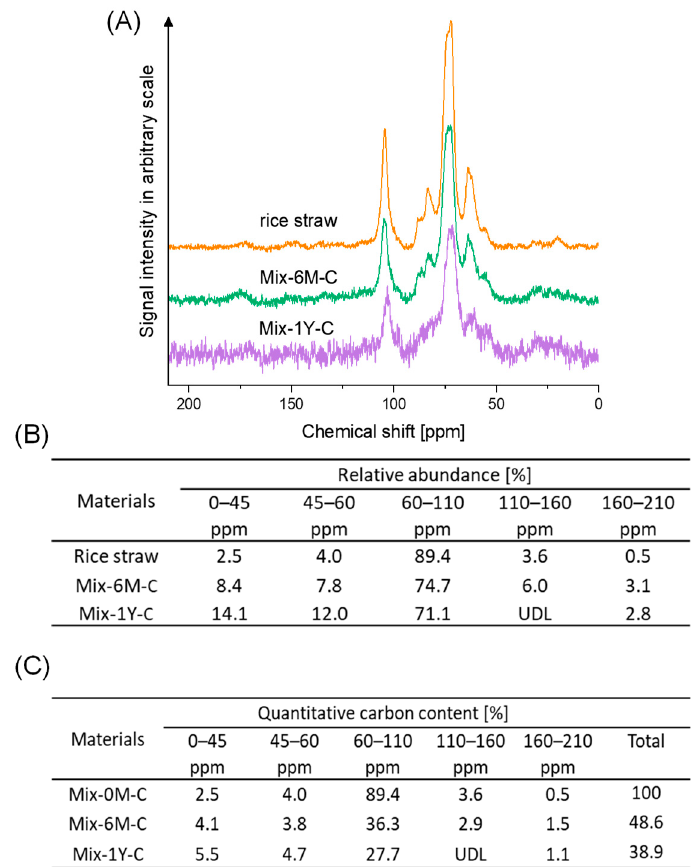
Figure 3. ( A ): 13 C CP/MAS NMR spectra of rice straw-artificial soil mixtures with six months and one year of humification (Mix-6M-C, Mix-1Y-C) and rice straw only. ( B ): The relative abundance of different carbon groups in 13 C CP/MAS NMR spectra calculated by integrating signal intensities with chemical shift range and expressed as percentages of the total area (0–210 ppm). ( C ): Quantitative changes in carbon groups based on elemental analysis and 13 C CP/MAS NMR spectra. Assignment of different carbon groups was as follows: 0–45 ppm, alkyl carbon; 45–60 ppm, N-alkyl carbon; 60–110 ppm, carbohydrate carbon; 110–160 ppm, aromatic carbon; and 160–210 ppm, carbonyl carbon [59]. The UDL was below the detection limit, where the signal-to-noise ratio was smaller than 2.